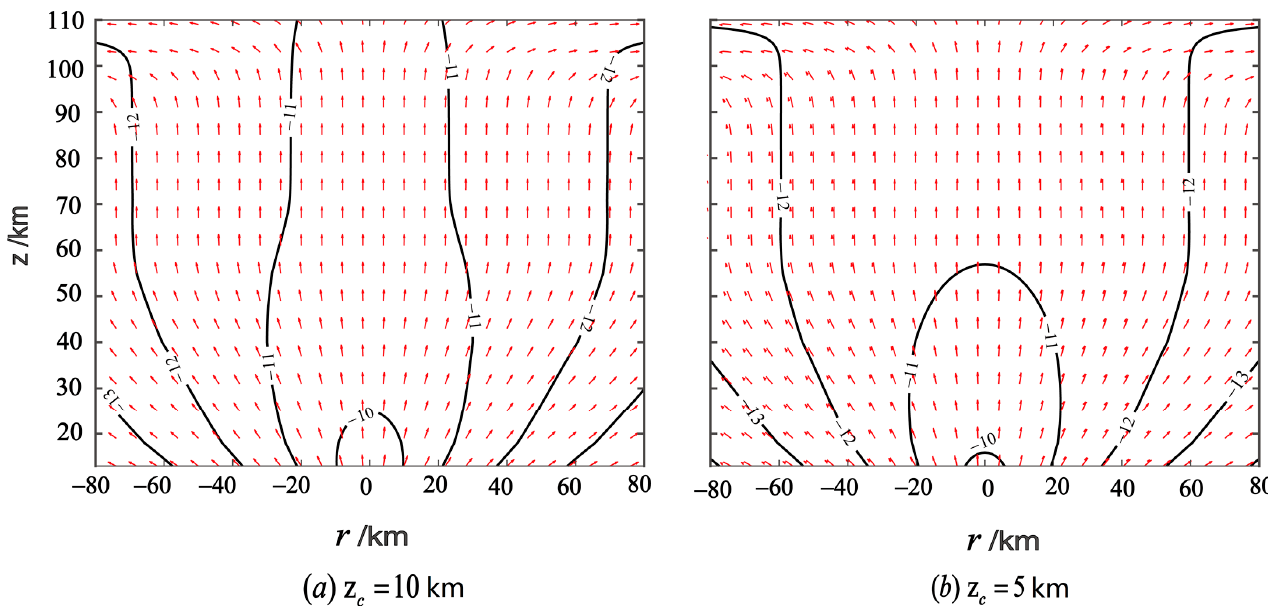
Figure 4. On the left is a contour map of the conduction current density of a 1 C thundercloud centered at 10 km. On the right is a contour map of the conduction current density over a thundercloud caused by a 1 C thundercloud centered at 5 km. The units of the current density are A/m 2 .